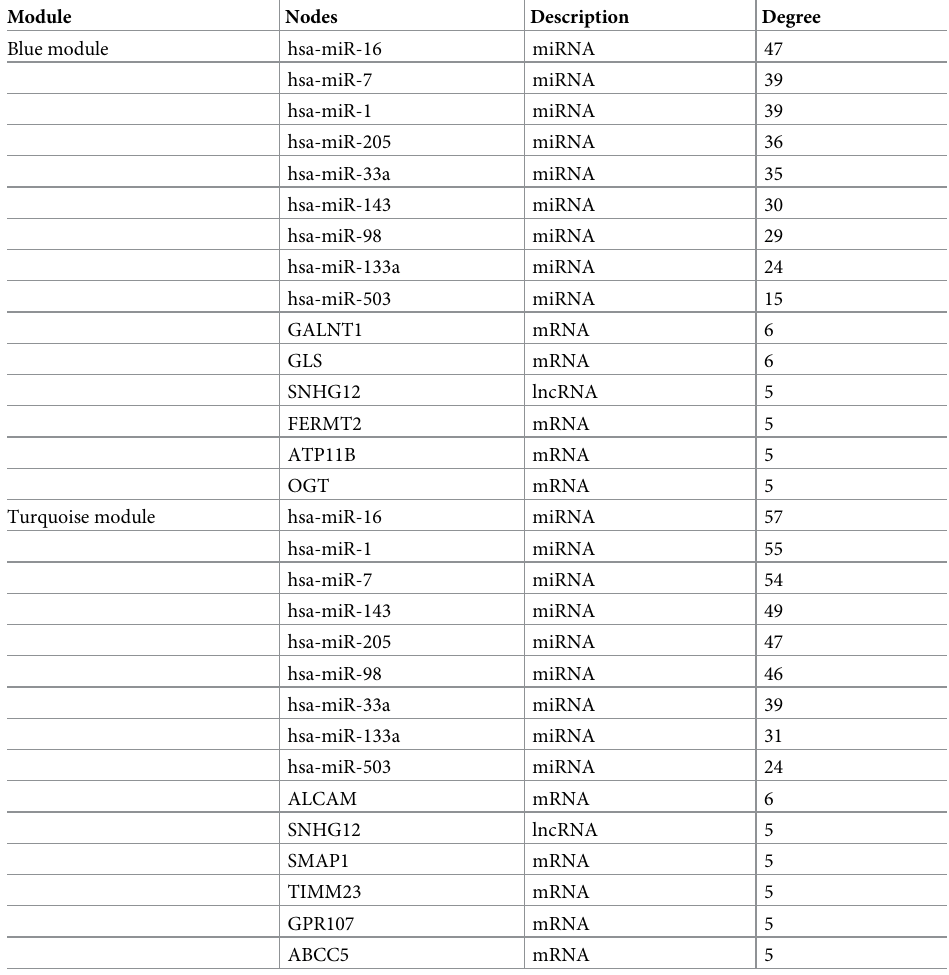
Table 3. The top 15 nodes in the competing endogenous RNA (ceRNA) regulatory network in the blue module and the turquoise module.